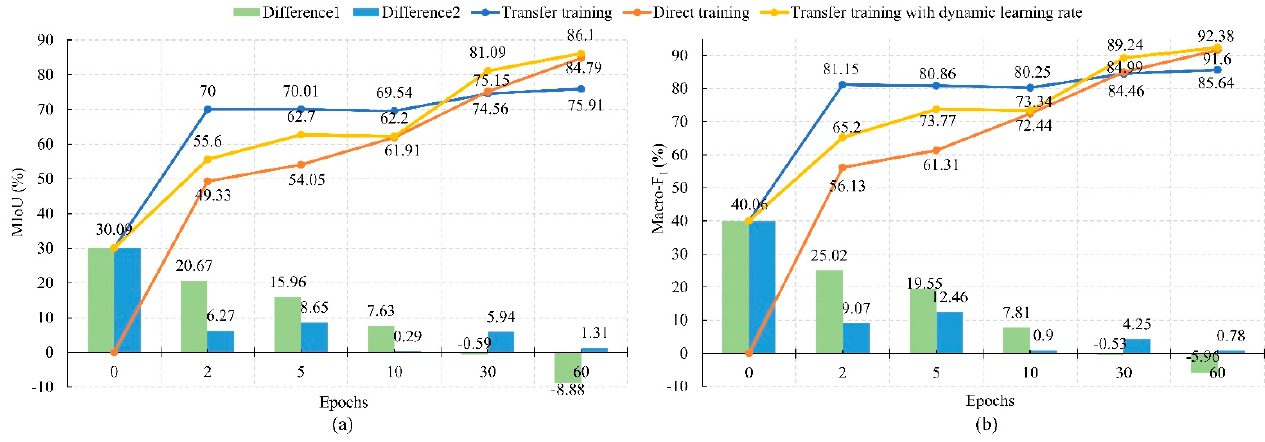
Figure 21. The accuracy curves of transfer training, direct training, and transfer training with dynamic learning rate. ( a ) The MIoU values of three training strategies. ( b ) The Macro-F1 values of three training strategies. Difference1 is the discrepancies in accuracy between direct training and transfer training. Difference2 represents the discrepancies in accuracy between direct training and transfer training with dynamic learning rates.